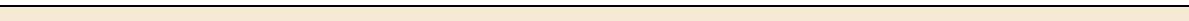
Table 2 Results of Kinetic Isotope Effects and Proton Inventory Measurements for CoPc-P4VP with different P4VP loadings P4VP